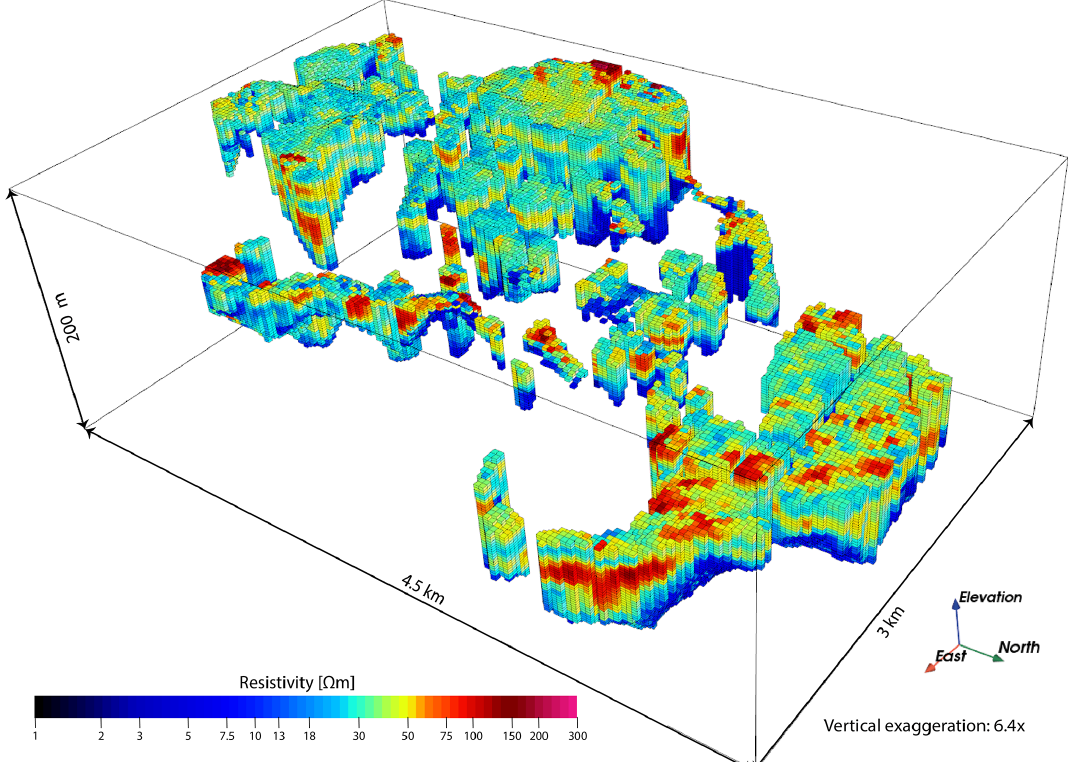
Figure 7. 3D resistivity grid from the tTEM model results in a grid equal to the simulation